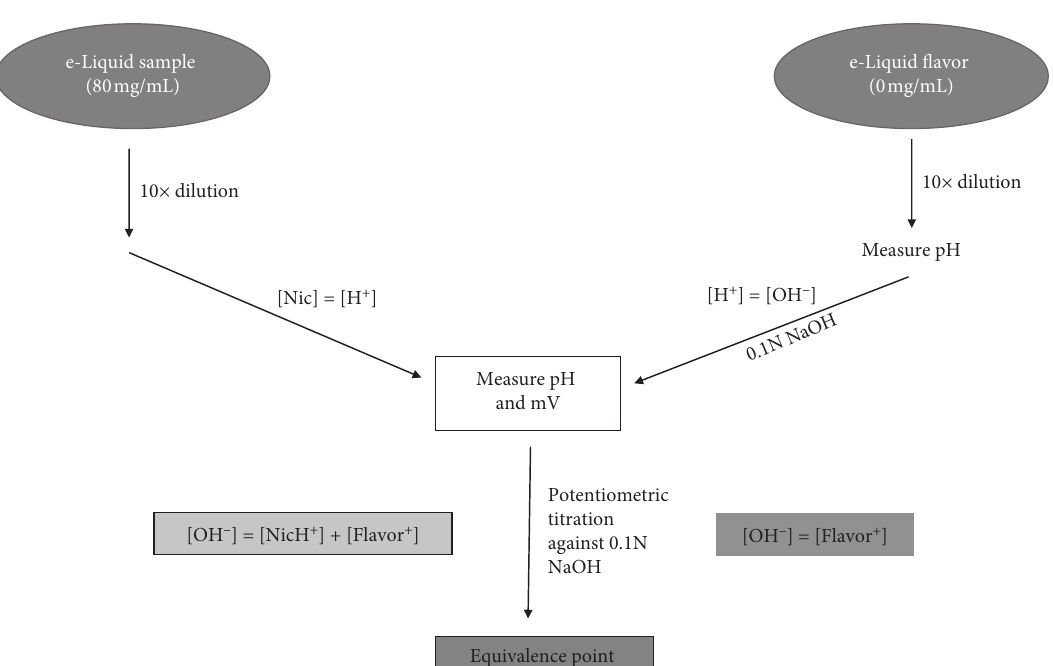
Figure 2: Schematic of methodology of potentiometric titration to measure protonated nicotine [NicH +